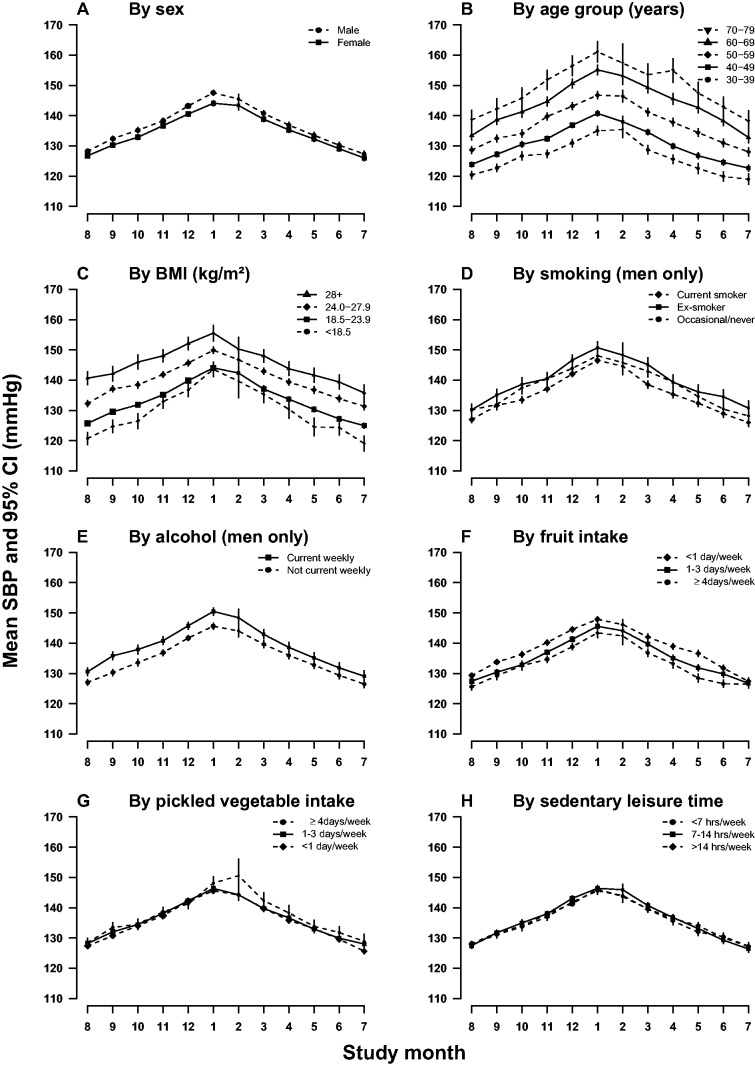
Mean SBP by study month in subgroups: (A) by sex; (B) age group (years); (C) by BMI (kg/m2); (D) by smoking (men only); (E) by alcohol drinking (men only); (F) by fruit intake; (G) by pickled vegetable intake; (H) by sedentary leisure time (h/day). SBP, systolic blood pressure; DBP, diastolic blood pressure; CI, confidence interval. SBP and DBP values were adjusted for age, sex and education and plotted by the mean dates of survey in that month. Mean values and 95% CIs of SBP are shown in black points and vertical lines. Sizes of points are inversely proportional to the standard errors of the point estimates.